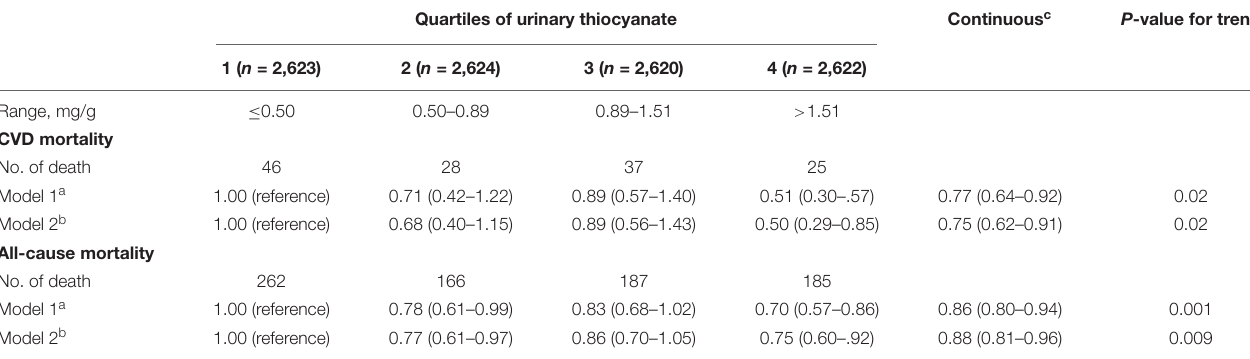
TABLE 2 | Associations between urinary thiocyanate and cardiovascular disease and all-cause mortality among non-smoking adults. Quartiles of urinary thiocyanate Continuous c P -value for trend